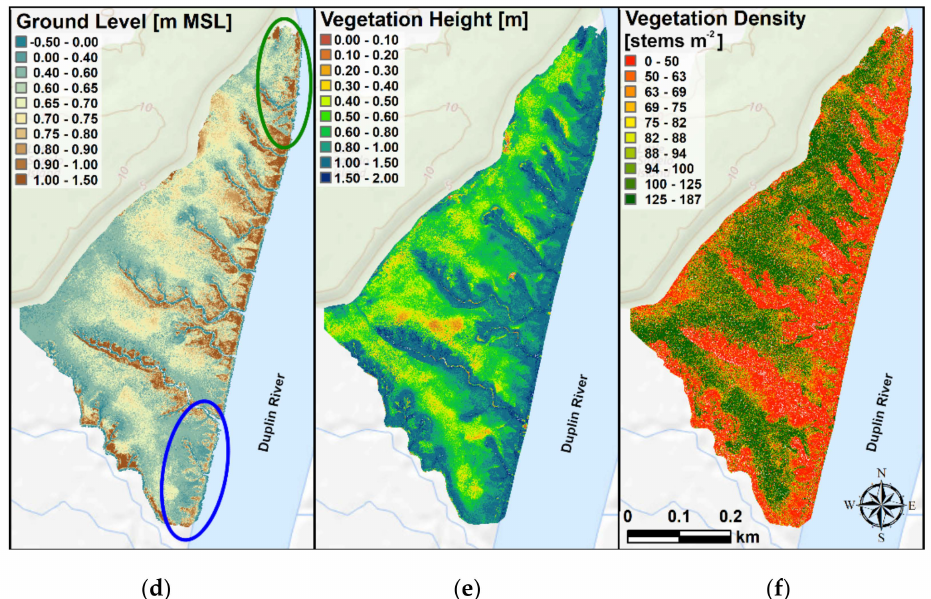
Figure 5. Maps of: ( a ) LiDAR-UAV-based ground elevation. ( b ) LiDAR-UAV-based vegetation height. ( c ) LiDAR-based vegetation density. ( d ) Digital Aerial Photogrammetry (DAP)-UAV-based ground elevation. ( e ) DAP-UAV-based vegetation height. ( f ) DAP-UAV-based vegetation density. The green and blue circles in ( d ) indicate the areas where the imagery dataset suffers georeferentiation errors, due to the limited presence of GCPs. The background is the USGS national